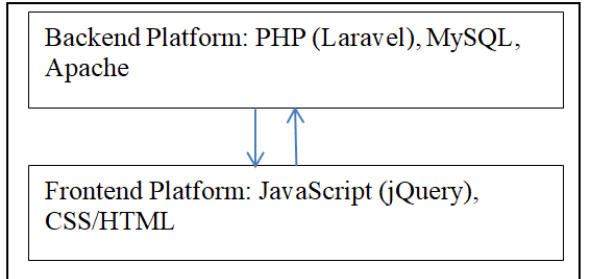
Figure 2. Software